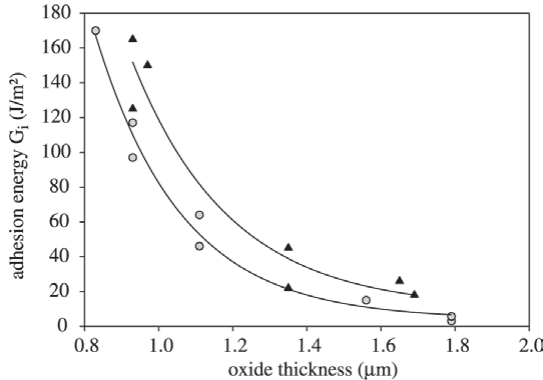
Figure 9. Adhesion energy as a function of scale thickness for oxides isothermally grown at 900 °C on Fe-18Cr-TiNb in oxygen (circles) or in water vapour (triangles). Oxidant (O tial pressure: 150